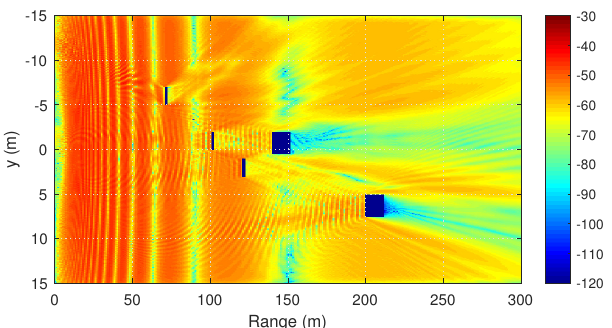
Figure 12. Scattering on vehicles. Two-dimensional distribution of the signal level (dBm) at the height of 1.5 m, calculated by the two-way PE method.